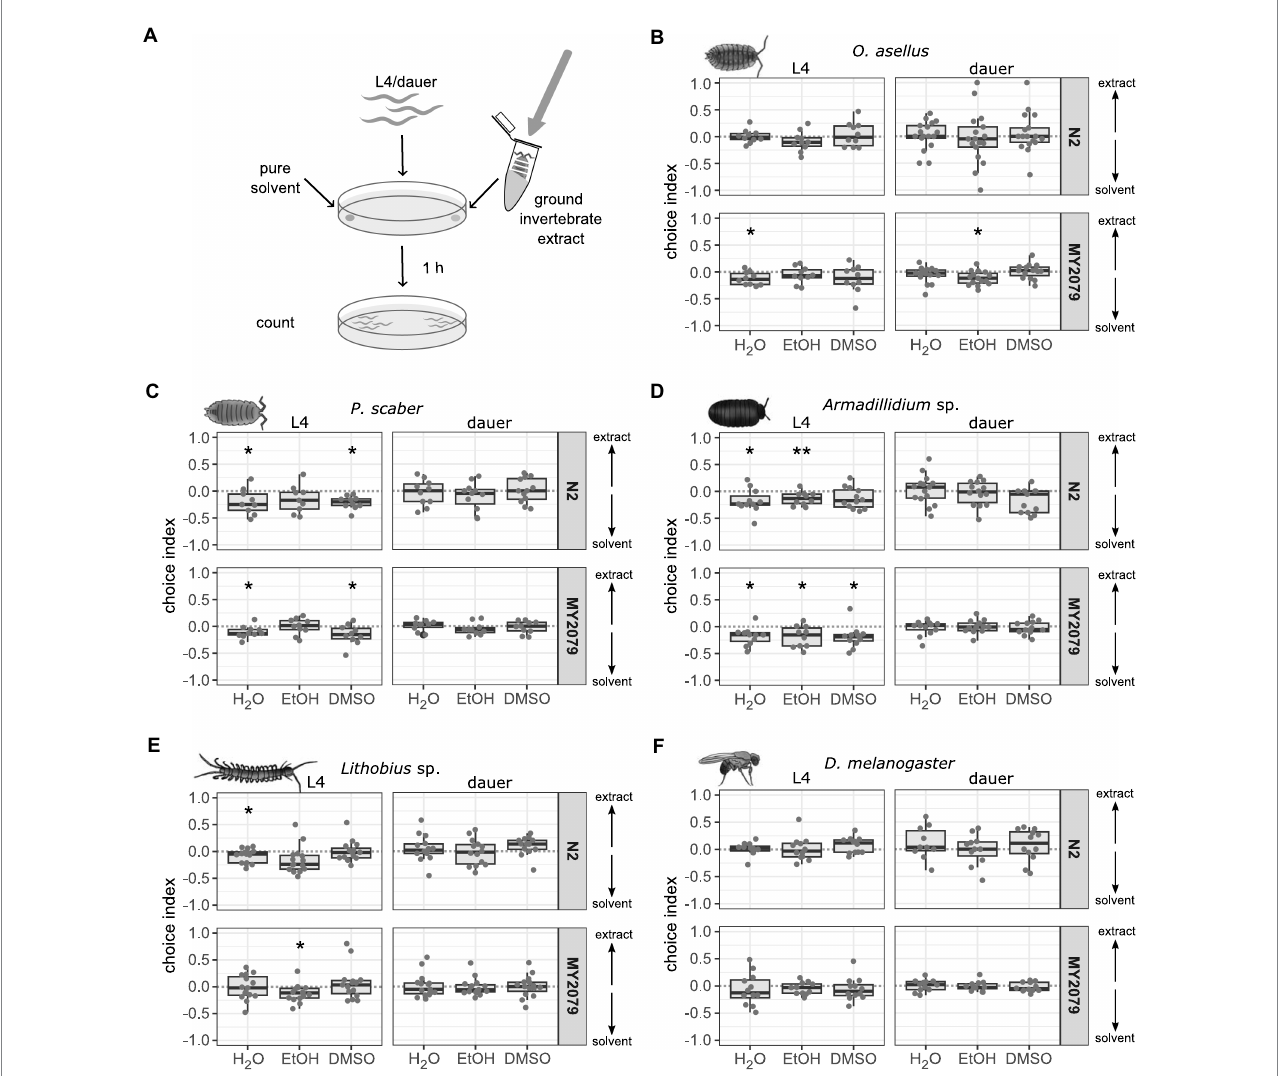
FIGURE 2 Caenorhabditis elegans strains N2 and MY2079 are not attracted to extracts from ground invertebrates in three solvents. (A) Caenorhabditis elegans strains N2 and MY2079 were grown on OP50 and used as L4 or dauer larvae to evaluate their chemotactic response toward extracts obtained from invertebrates ground in three different solvents. A positive choice index indicates attraction to the extract from (B) Oniscus asellus ( n = 9–17), (C) Porcellio scaber ( n = 9–14), (D) Armadillidium sp. ( n = 11–18), (E) Lithobius sp. ( n = 13–15), or (F) Drosophila melanogaster ( n = 11–12). A negative choice index indicates repulsion from the invertebrate (solvent), a choice index of 0 indicates equal choice of both sides. For comparison of choice indices with 0, the Wilcoxon signed-rank test with false discovery rate correction for multiple testing was applied. Data are presented as boxplots with the median as a thick horizontal line, the interquartile range as box, the whiskers as vertical lines, and each replicate depicted by a dot. From left to right each panel shows boxes representing deionized water (H 2 O), ethanol (EtOH), and dimethyl sulfoxide (DMSO) extracts (with 30–250 worms per replicate). Significance is designated to the following scale: ** p < 0.01, * p <